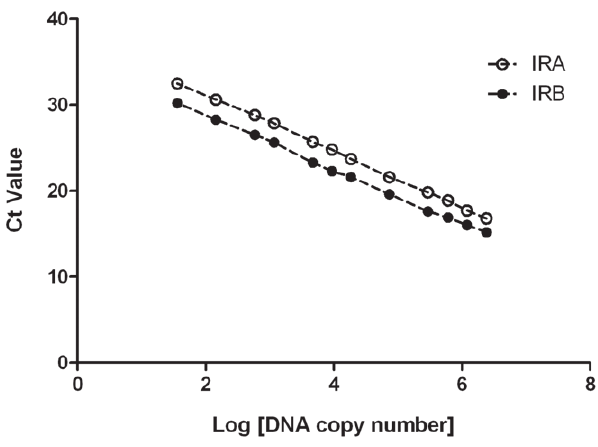
Figure 1. IR-A and IR-B assay serial dilution curves. Probe sensitivity was tested by performing IR-A or IR-B TaqMan qRT-PCR assays with a serial dilution of approximately 10 7 to 10 copies of plasmid DNA of either IR-A, IR-B, or an empty vector control. The Y axis represents cycle-threshold (Ct) values and the X axis represents log DNA copy number. The slope and regression coefficient ( r 2 value) of the standard dilution curve for the IR-A assay are -3.259 and 0.9992, respectively. The slope and regression coefficient ( r 2 value) of the standard dilution curve for the IR-B assay are -3.155 and 0.9989, respectively.